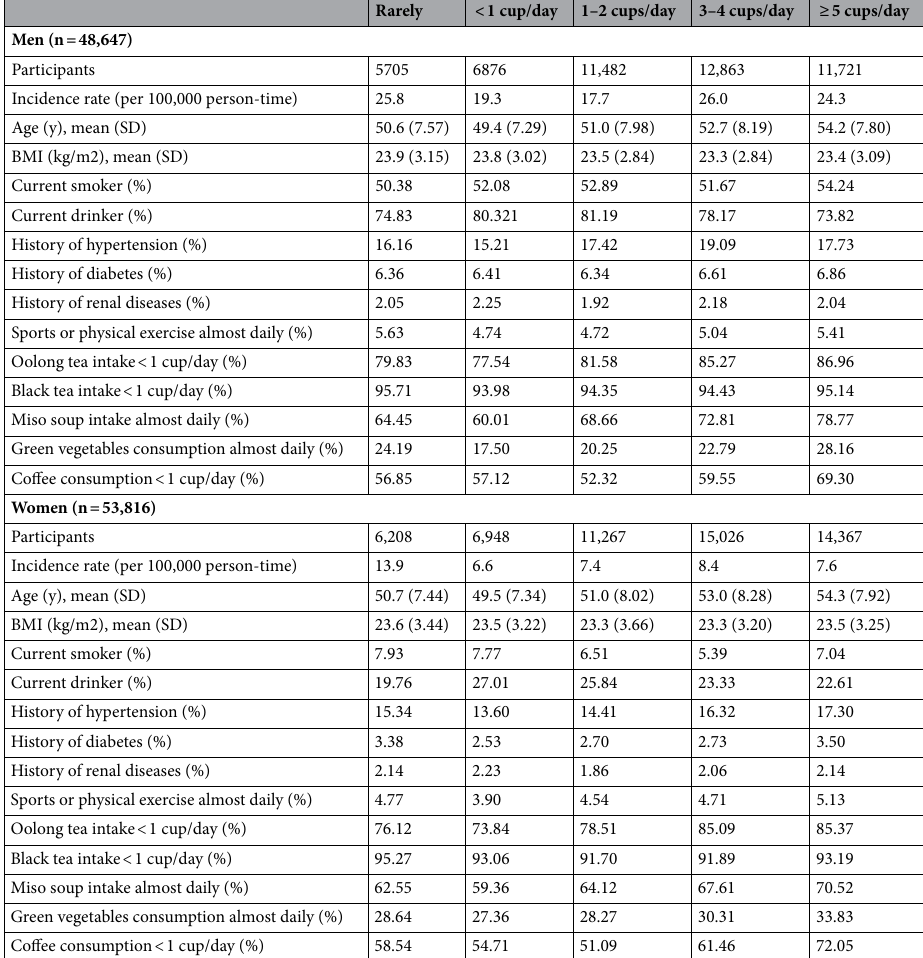
Table 1. Baseline characteristics of JPHC Study participants according to green tea consumption (n = 102,463). a ANOVA test for continuous variables or chi-square test for categorical variables; b D = standard